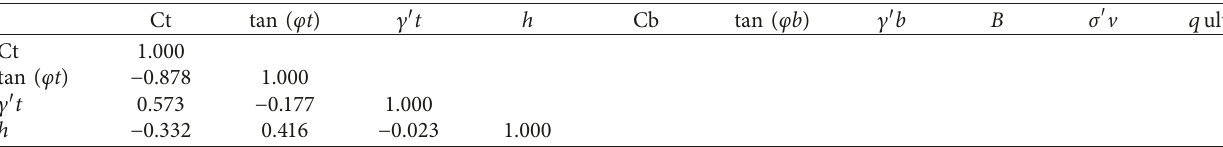
Table 3: Correlation matrix of Pearson for the studied